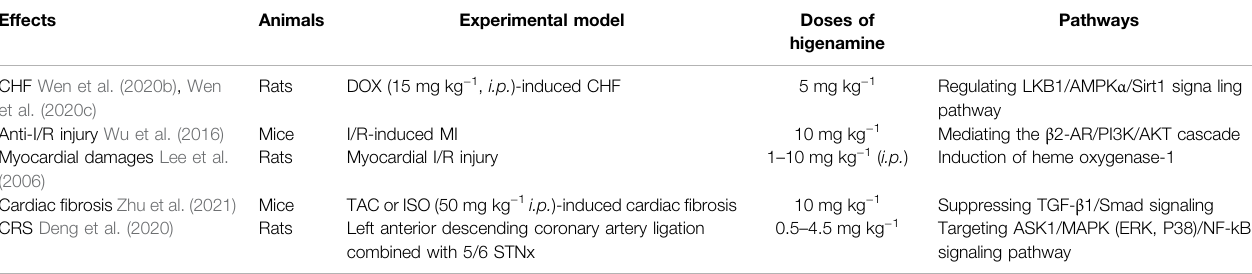
TABLE 2 | In vivo pharmacological activities of higenamine in heart disease.